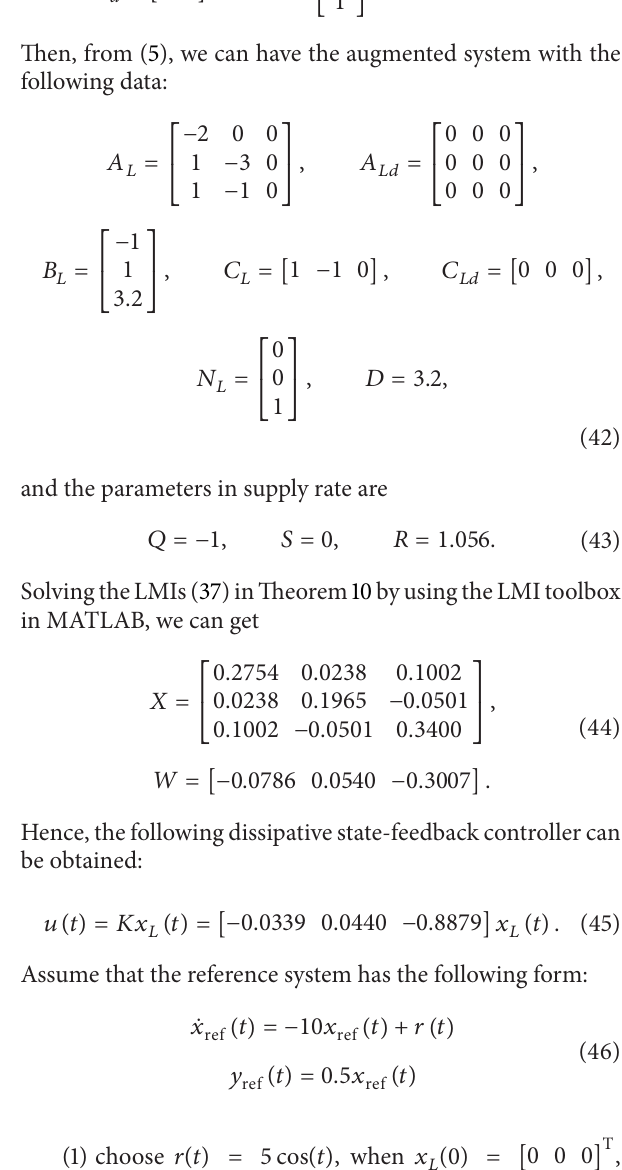
(1) choose 𝑟(𝑡) = 5 cos (𝑡) , when 𝑥 𝐿 (0) = [0 0 0] T , (0) = 0 , output tracking trajectory is shown in 𝑥 ref (0) = 1 , output Figure 1; when 𝑥 𝐿 (0) = [ 1 0 1 ] T , 𝑥 ref tracking trajectory is shown in Figure 2; (0) = (2) choose 𝑟(𝑡) = 0 , when 𝑥 𝐿 (0) = [0 0 0] T , 𝑥 ref 0 , output tracking trajectory is shown in Figure 3; (0) = 1 , output tracking when 𝑥 𝐿 (0) = [1 0 1] T , 𝑥 ref trajectory is shown in Figure